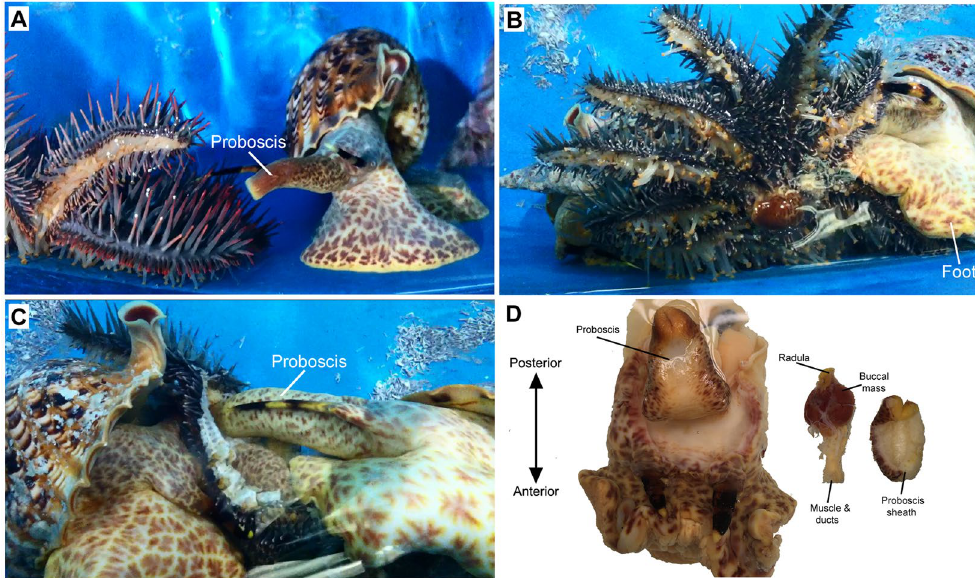
Figure 1. Charonia tritonis attack on a Crown-of-Thorns starfish (COTS). ( A ) C. tritonis withdraws proboscis in preparation for attack. ( B ) C. tritonis uses muscular foot to immobilize COTS. ( C ) Two C. tritonis feeding on a COTS, proboscis of the snail on the right penetrating COTS body wall. ( D ) Location of the proboscis, and internal organs including buccal mass, ducts and radula in C. tritonis